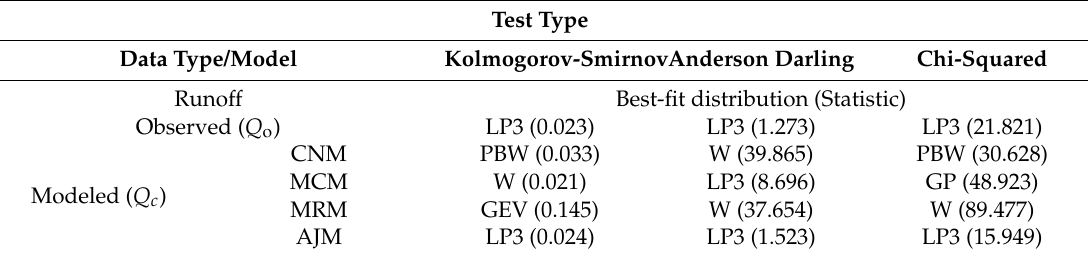
Table 5. Comparison of observed and modeled runoff based on best-fit distributions